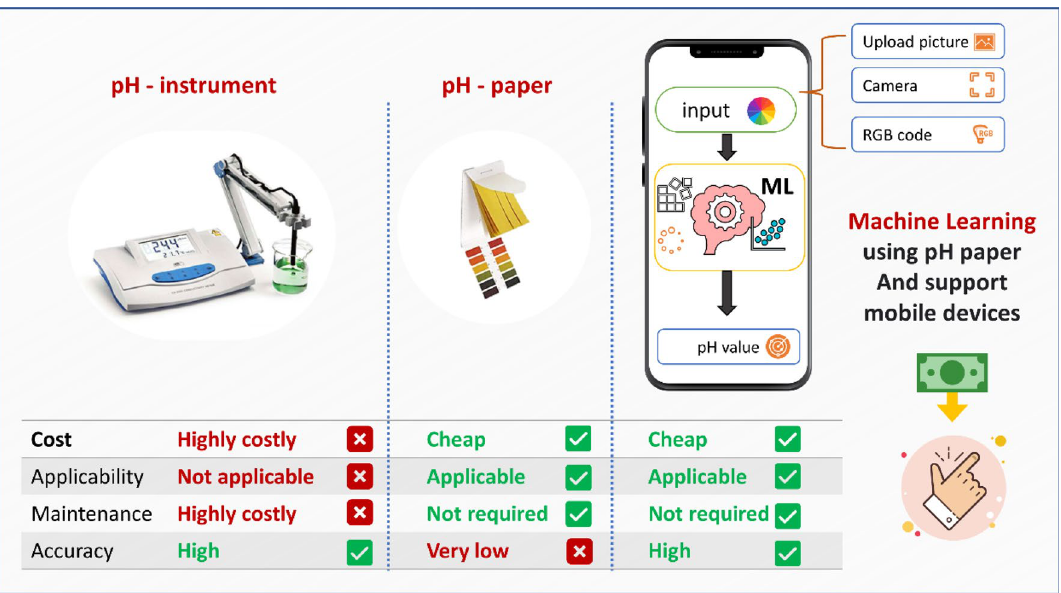
Figure 8. Comparison of pH instrument, pH paper, and the current